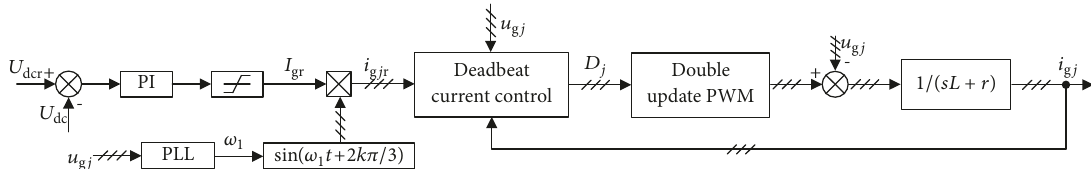
Figure 2: Diagram of the double update PWM method for photovoltaic grid-connected inverter based on the deadbeat control.